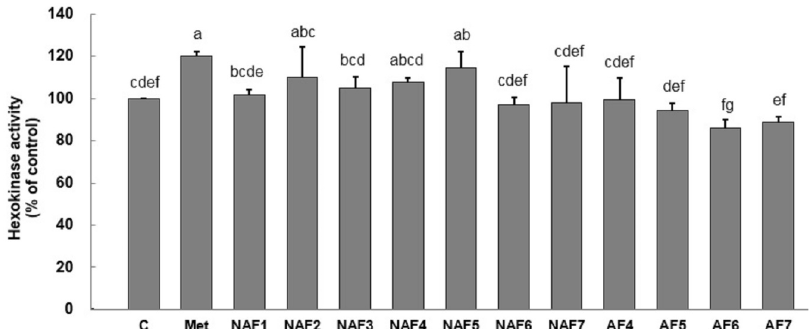
Fig. 2: Effect of mulberry extracts on hexokinase activity of HepG2 cells. C, control; MET, metformin; NAF, nonanthocyanin fraction (maturity stage 1-7); and AF, anthocyanin fraction (maturity stage 4-7). Bars represent means ± standard deviations (n=3). Different letters (a-g) above the bars indicate significant differences by Duncan’s test at P <0.05.